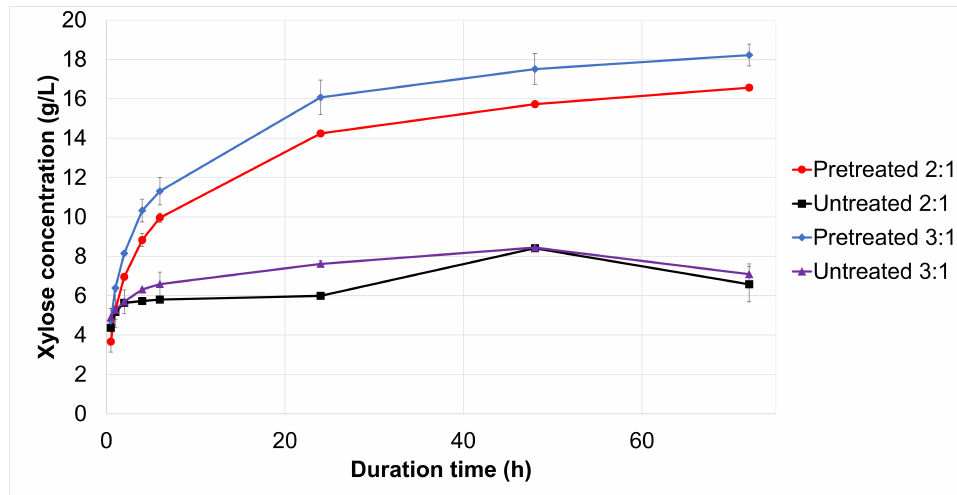
Figure 5. Xylose concentration for untreated and pretreated corn stover. Experiments were performed for two different ratios of CTec2:HTec2 enzymes.